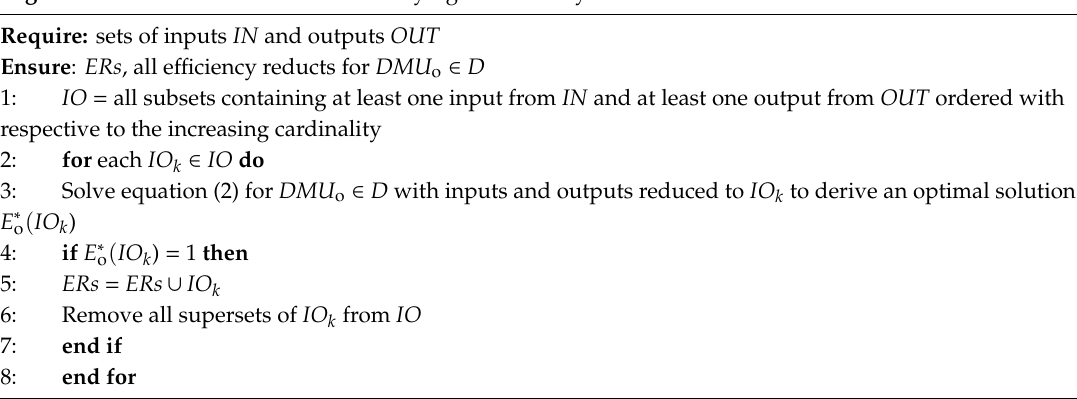
Algorithm 1. Additive method for identifying all e ffi ciency